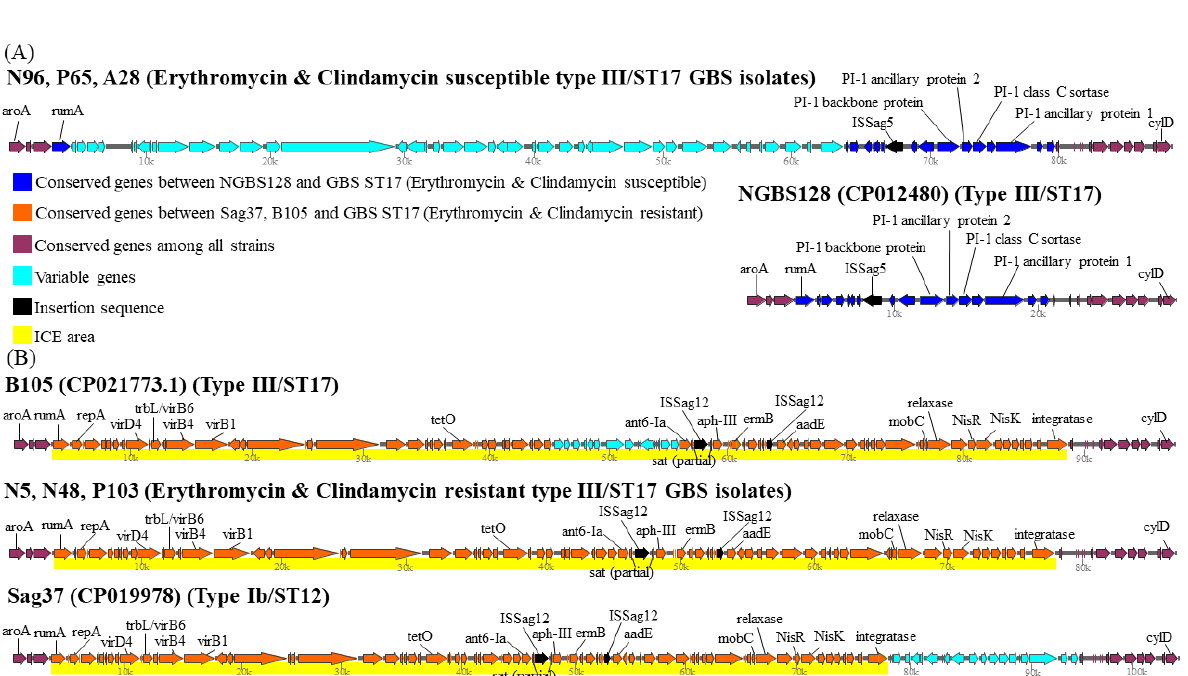
Figure 3. Pilus Island 1 is a hotspot for integration of integrative and conjugative element, ICE Sag37 , carrying antimicrobial genes and virulence genes. ( A ) The top schematic shows the region between the beginning of gene aroA and the end of gene cylD (from nucleotides 589,950 to 619,400) in the genome of three antimicrobial susceptible strains (N96, P65, A28) and comparison with that depicted in the second schematic for the region of reference strain NGBS128. This region contains several PI-1 genes (blue) and ISsag5. ( B ) Loss of PI-1 and ISSag5 is replaced by acquisition of an integrative and conjugative element (ICE), ICESag37, carrying multiple resistance genes and virulence genes in three antimicrobial resistant ST-17/III GBS strains, the reference strain B105 and Sag37 (type Ib/ST12). The bottom schematic show that in these antimicrobial resistant GBS strains, the site-specific integration of ICESag37, starting from the beginning of rumA to the end of integratase, is clearly visible and shown in yellow color. Conserved genes are indicated in purple, variable genes are indicated in light blue. Antimicrobial resistance genes are indicated.